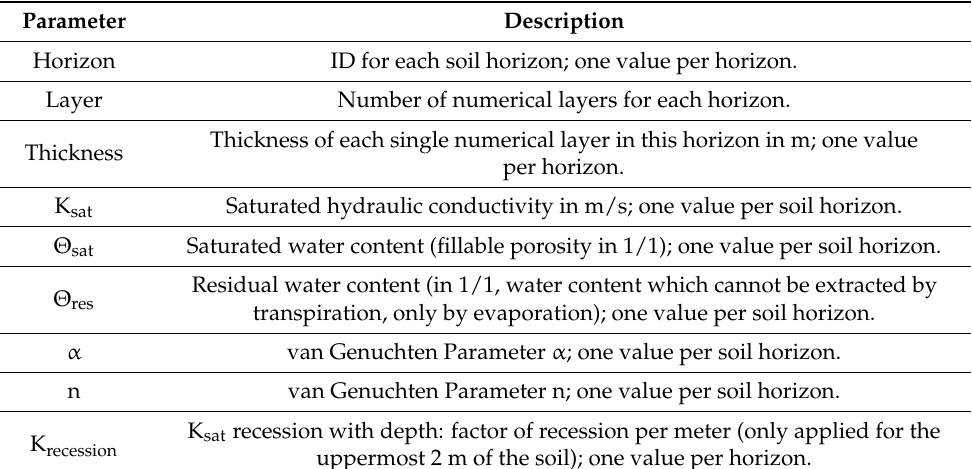
Table 1. Mandatory parameters to describe a soil horizon in the WaSiM control